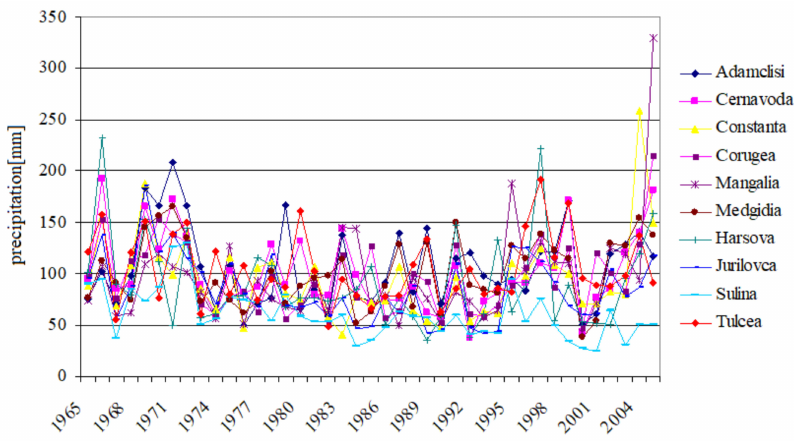
Figure 2. Maximum annual precipitation